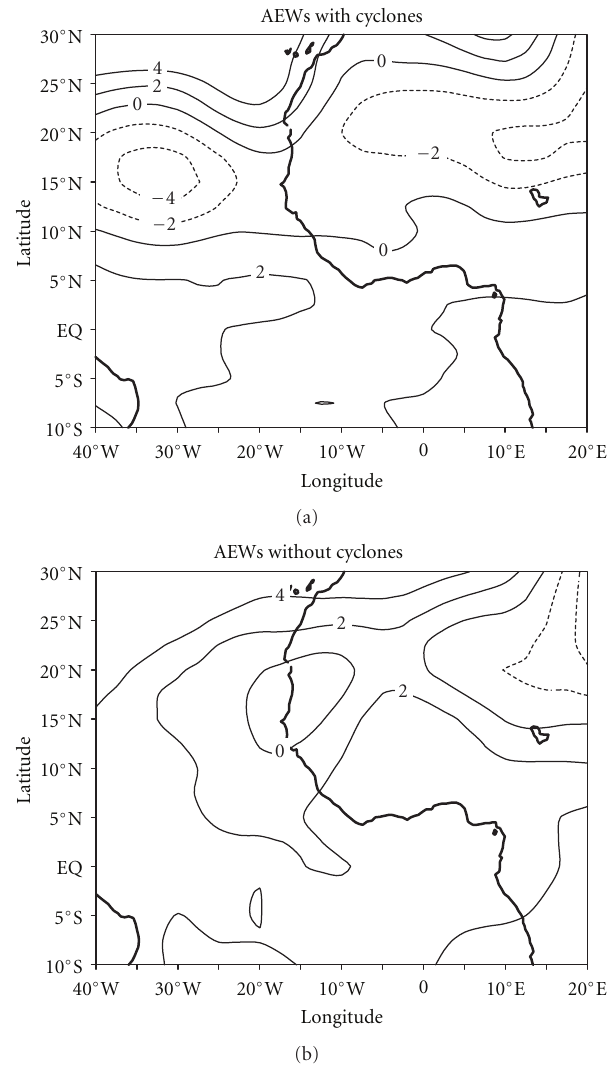
Figure 8: Anomaly of geopotential height at 850 hPa from the mean August–October 1989–2003 (m) for AEWs associated with cyclones (a) and for non-developing AEWs